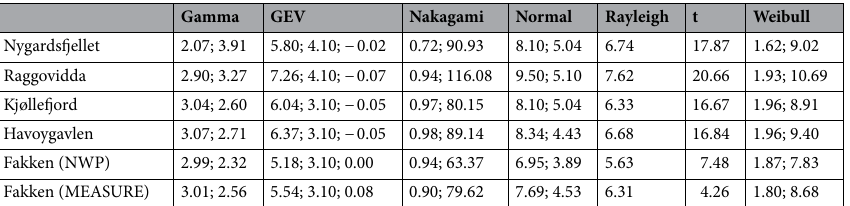
Table 5. The parameters of fitted PDFs. The parameters are shown with the form in Table 2 in order corresponding to each PDF.